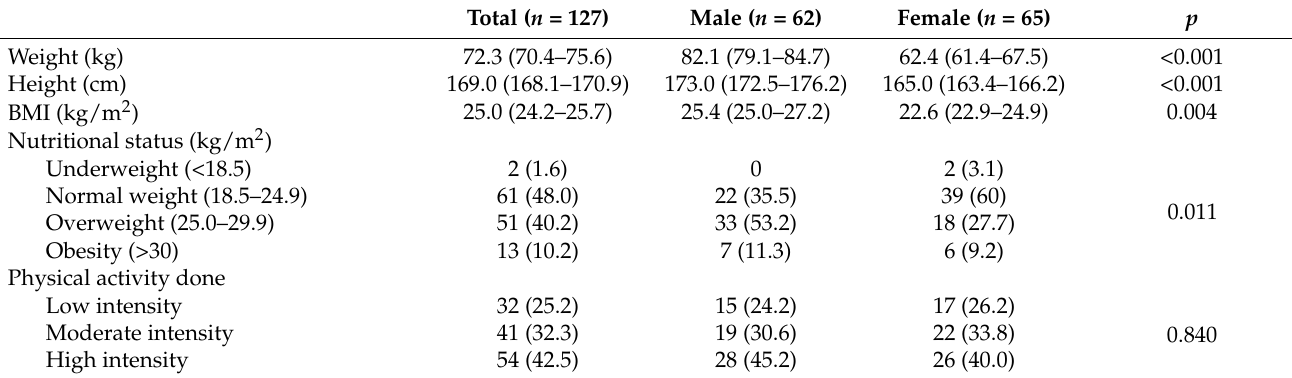
Table 2. Anthropometric characteristics and lifestyle of university professors of Melilla campus (University of Granada).